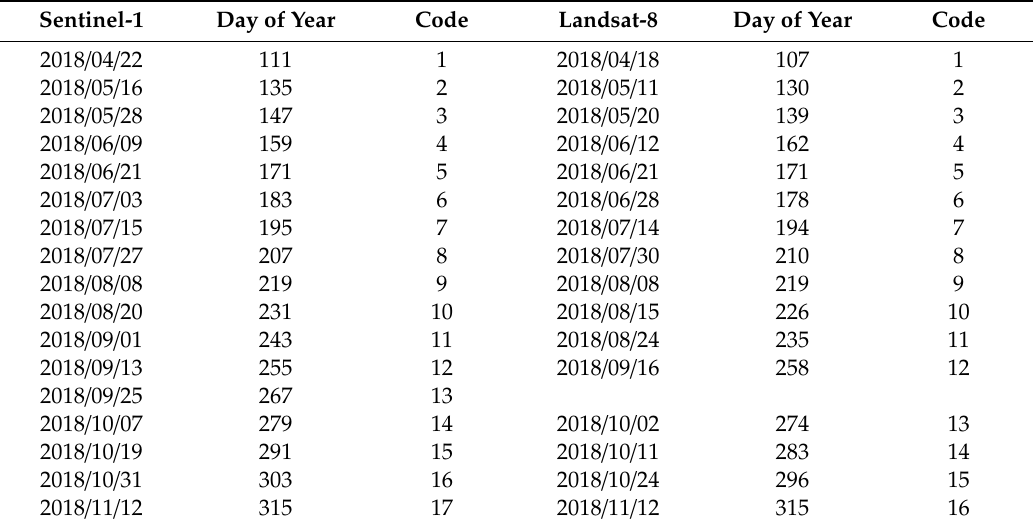
Table 1. Information on the experimental